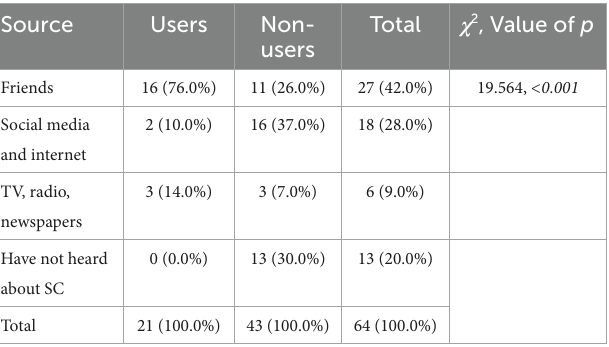
TABLE 2 Source of information regarding